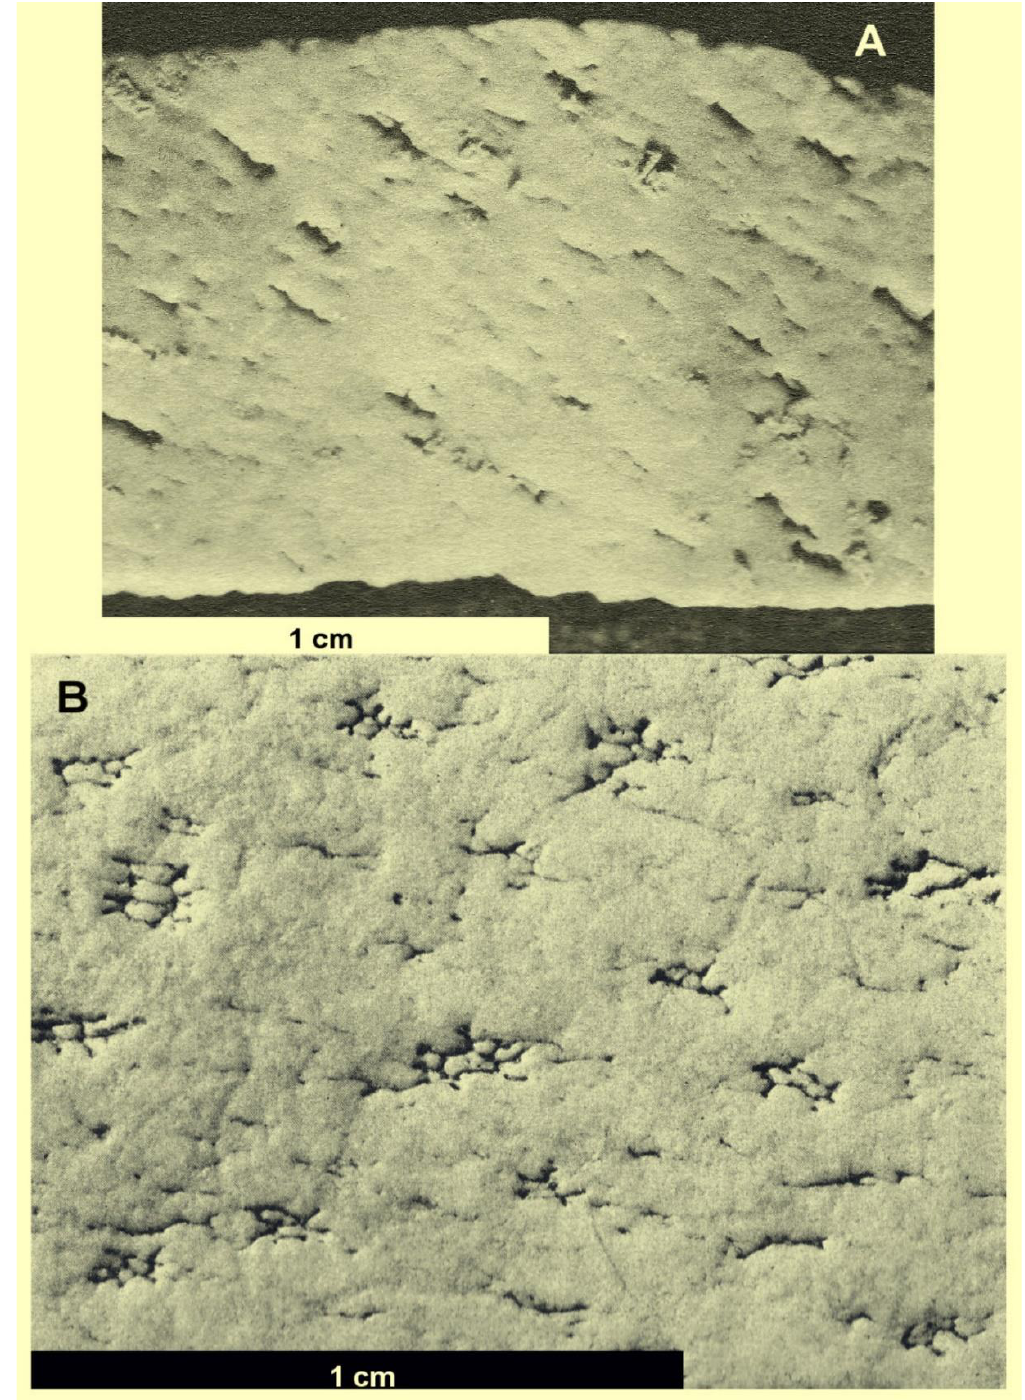
Figure 3. Pores on the outer surface of Psammornis eggshell fragments from Tunisia, ( A ) modified after Dughi and Sirugue [8]) and Mauritanaia (B, modified after Voisin [54].